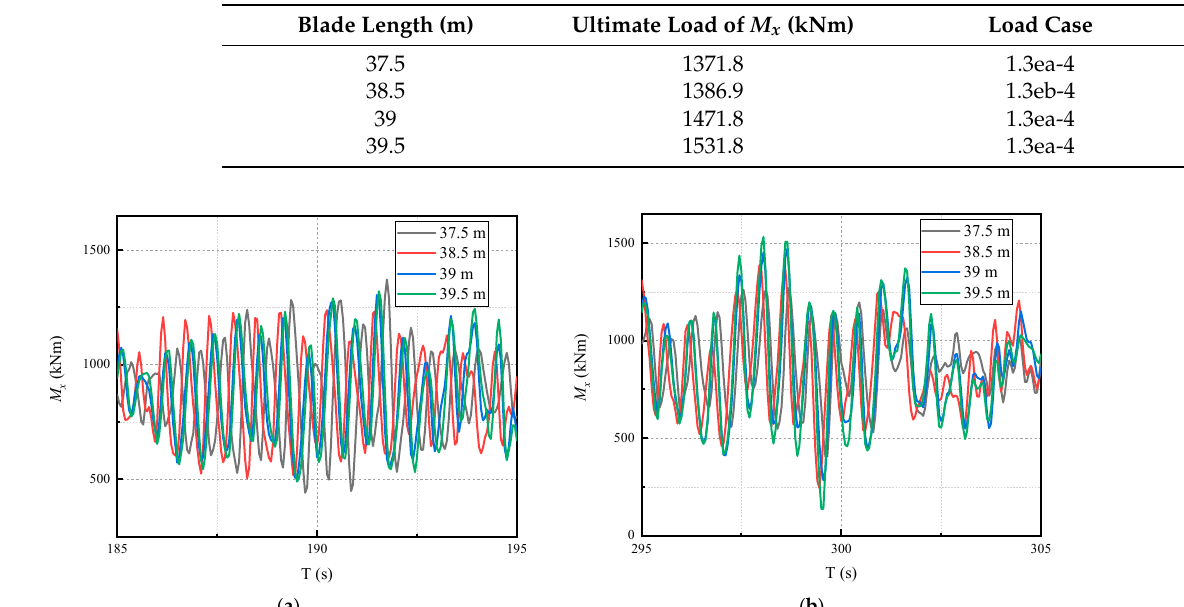
Table 10. Ultimate load M x at hub. (The label of the load case: the first letter refers to wind speed and “e” for 25 m/s; the second letter refers to yaw error, “a” for − 8 deg and “b” for 0 deg; the last number refers to the random seed number).